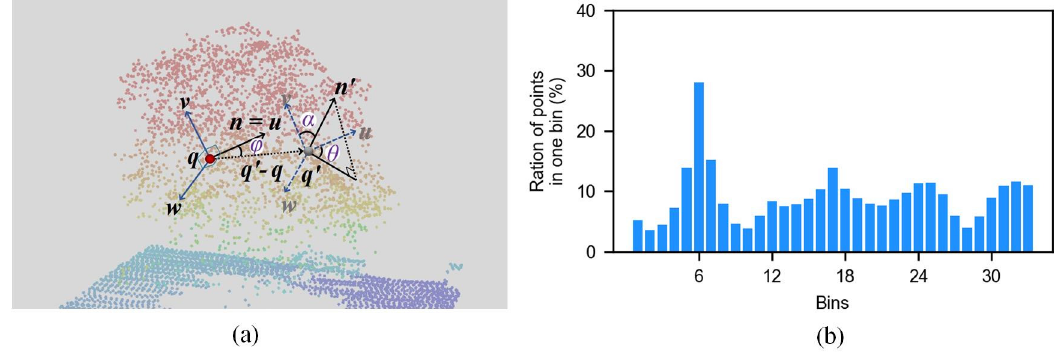
Figure 3. Angular representation (a) and an example of Fast point feature histograms (FPFH) (b) .